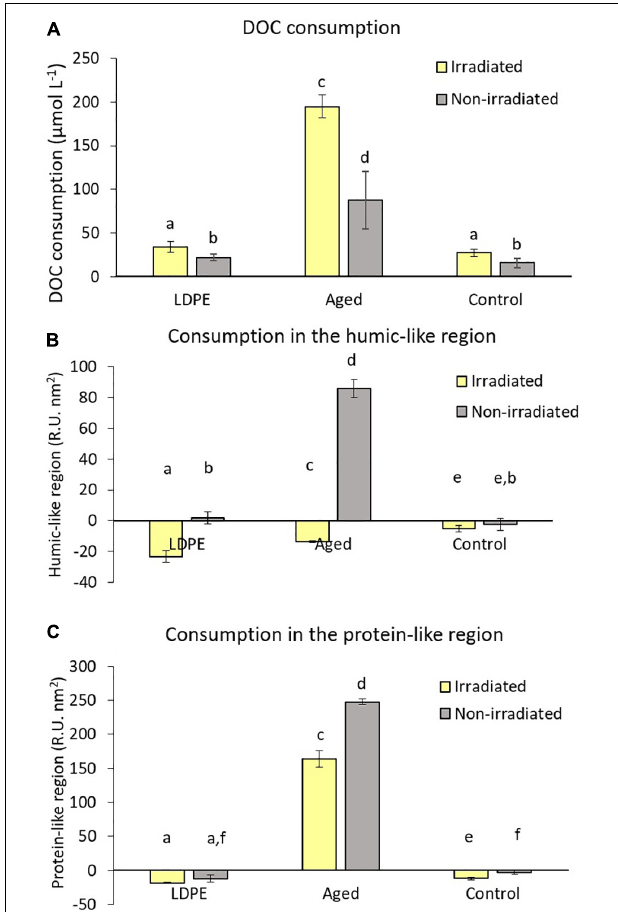
FIGURE 4 | Net variation of dissolved organic matter leached by LDPE and aged plastic after 4 days of bacterial biodegradation, calculated as the difference between the initial and final time points for (A) dissolved organic carbon consumption; Integrated fluorescence of dissolved organic matter in the (B) humic-like region and (C) protein-like region. Positive values indicate consumption while negatives indicate production. The same letter over different bars indicate non-significant differences between them. Error bars represent the standard deviation of the mean of the triplicate